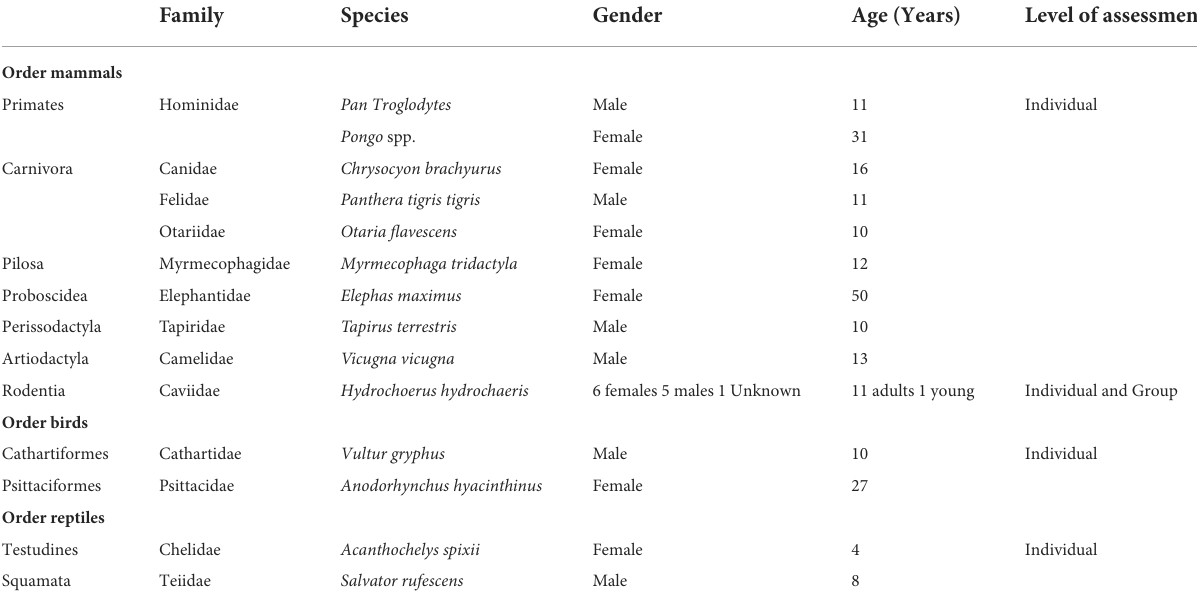
TABLE 2 Information about the animals on which the Ackonc-AWA protocol was tested. Family